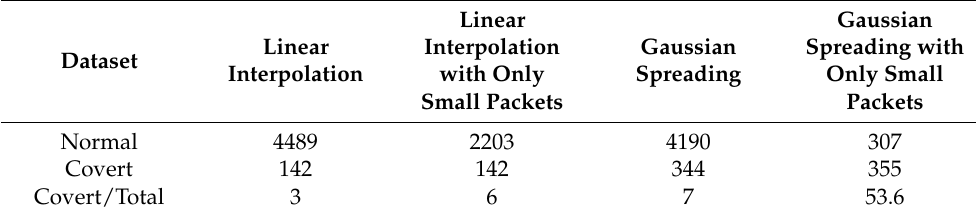
Table 2. Detailed datasets